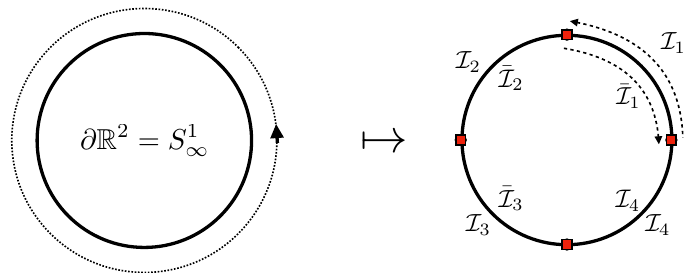
H a = 1 H d β ∈ 1 , because e i β ( φ ) is in 2 π 2 π N Z